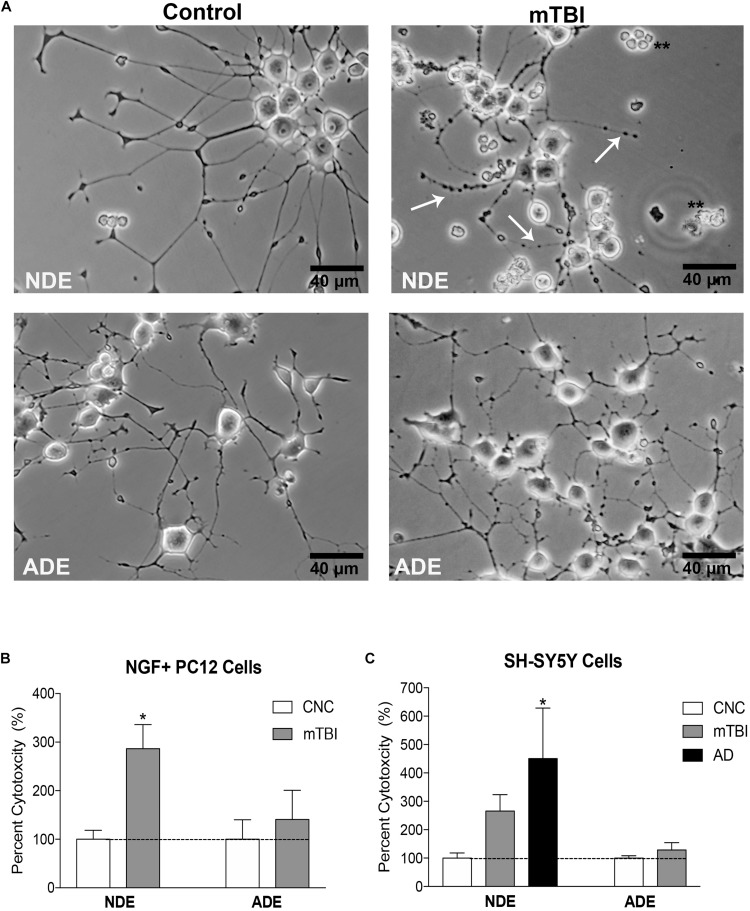
Plasma NDE cargo from individuals with mTBI compromise membrane integrity and are toxic to neuron-like cells in vitro. Differentiated PC12 cells and SH-SY5Y cells were incubated with 100 ng/ml of NDE and ADE for 48 h. Representative photomicrographs indicate exosome-induced cytotoxicity. Signs of cytotoxicity include dendritic blebbing (indicated by arrows), suppressed neurite outgrowth and cell death in NGF + PC12 cells (A). Compared to controls (100% viability), there was a threefold increase in exosome-induced cytotoxicity (LDH release) in wells that were treated with NDEs derived from service members with mTBI (B), ∗P < 0.05 vs. control, dashed horizontal line represents 100% viability. SH-SY5Y cells were treated with NDE and ADE preparations from control and mTBI service members and AD patients. A similar level of cytotoxicity was observed in cultured SH-SY5Y. A threefold increase in exosome-induced cytotoxicity (LDH release) was observed in wells that were treated with NDEs derived from mTBI samples and a fourfold increase exosome-induced cytotoxicity in wells that were treated with NDEs derived from AD samples as compared to NDEs derived from control samples (C). Non-parametric t-test; ∗P < 0.05 vs. control, dashed horizontal line represents 100% viability.